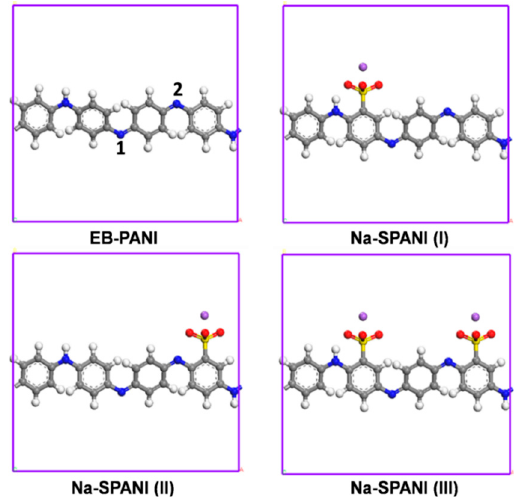
Figure 2. The monomers and adsorption sites of EB-PANI, Na-SPANI (I), Na-SPANI (II) and Na-SPANI (III) in periodic structure.